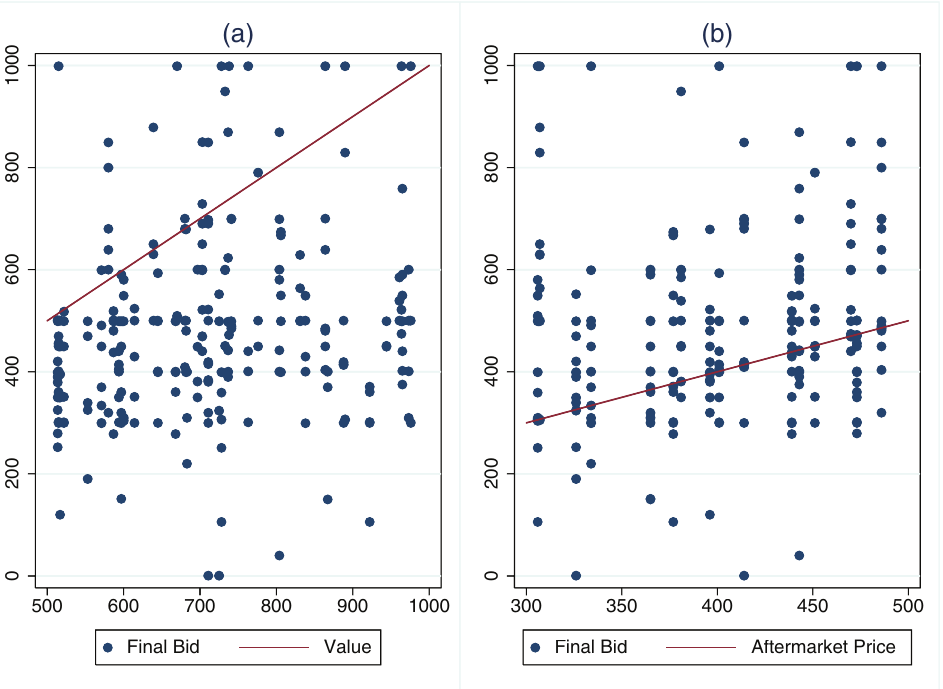
Figure 5. Scatterplots of final bids submitted by potentially spiteful bidders. Panel (a) shows the relationship between potentially spiteful final bids and values, and panel (b) shows the relationship between such bids and the aftermarket price. Each point represents a single bid, and the lines provide a reference showing where the bid equals each value or aftermarket price.